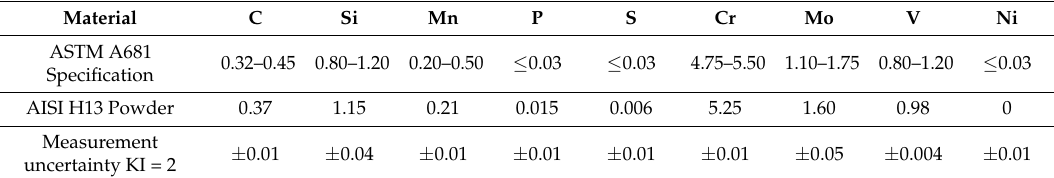
Table 1. Chemical composition of the AISI H13 powder (wt %).